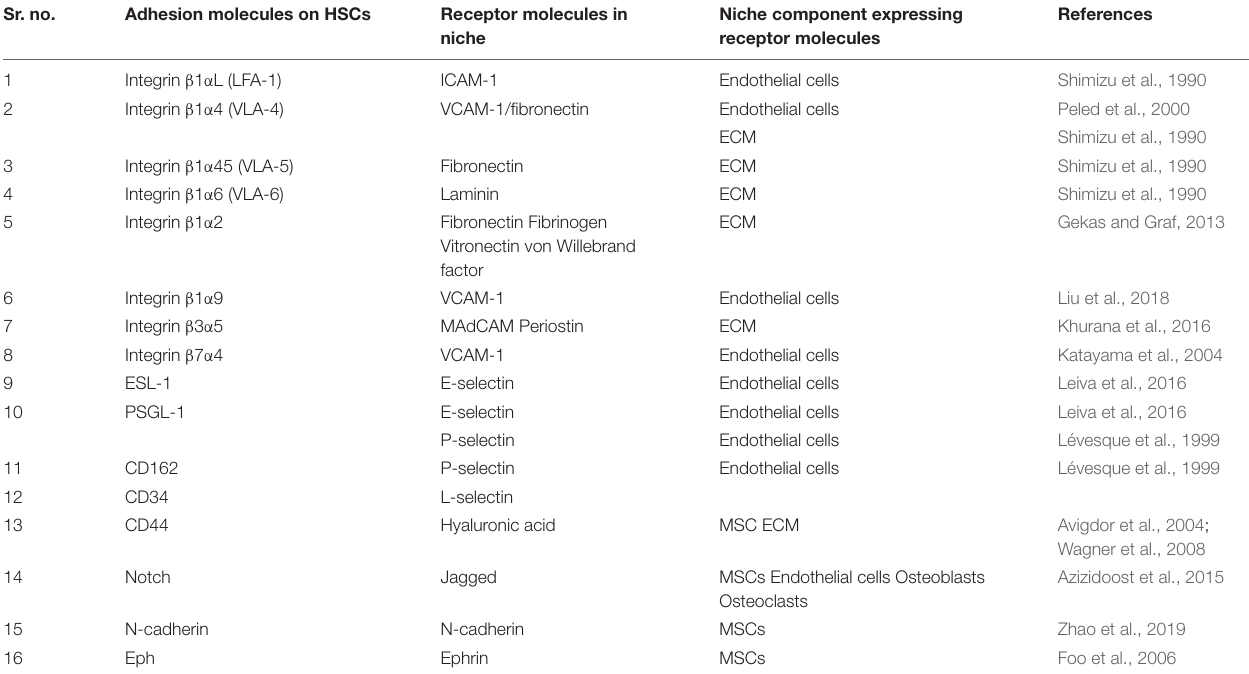
TABLE 1 | Summary of adhesion molecules expressed on hematopoietic stem cells and their counter receptors on niche components. Sr.